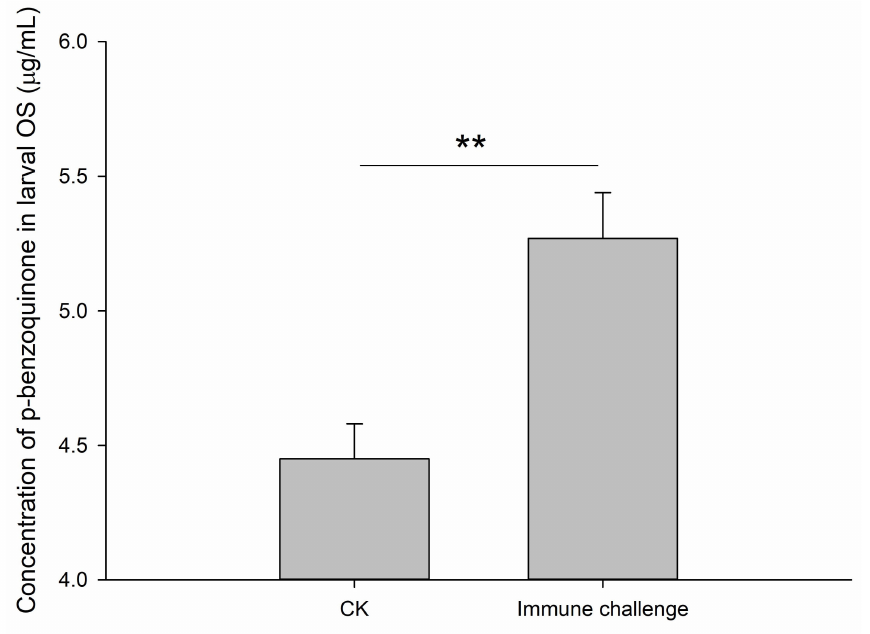
Figure 4. Quantification of p-benzoquinone chemical by gas chromatography-mass spectrometry (GC-MS) in oral secretions of RPW larvae after immune challenge with Metarhizium anisopliae . Data are shown as the mean ± SE from six independent biological repetitions. The asterisks marking the Student’s t test result indicate that there is a significant di ff erence between the two treatments (**, p <